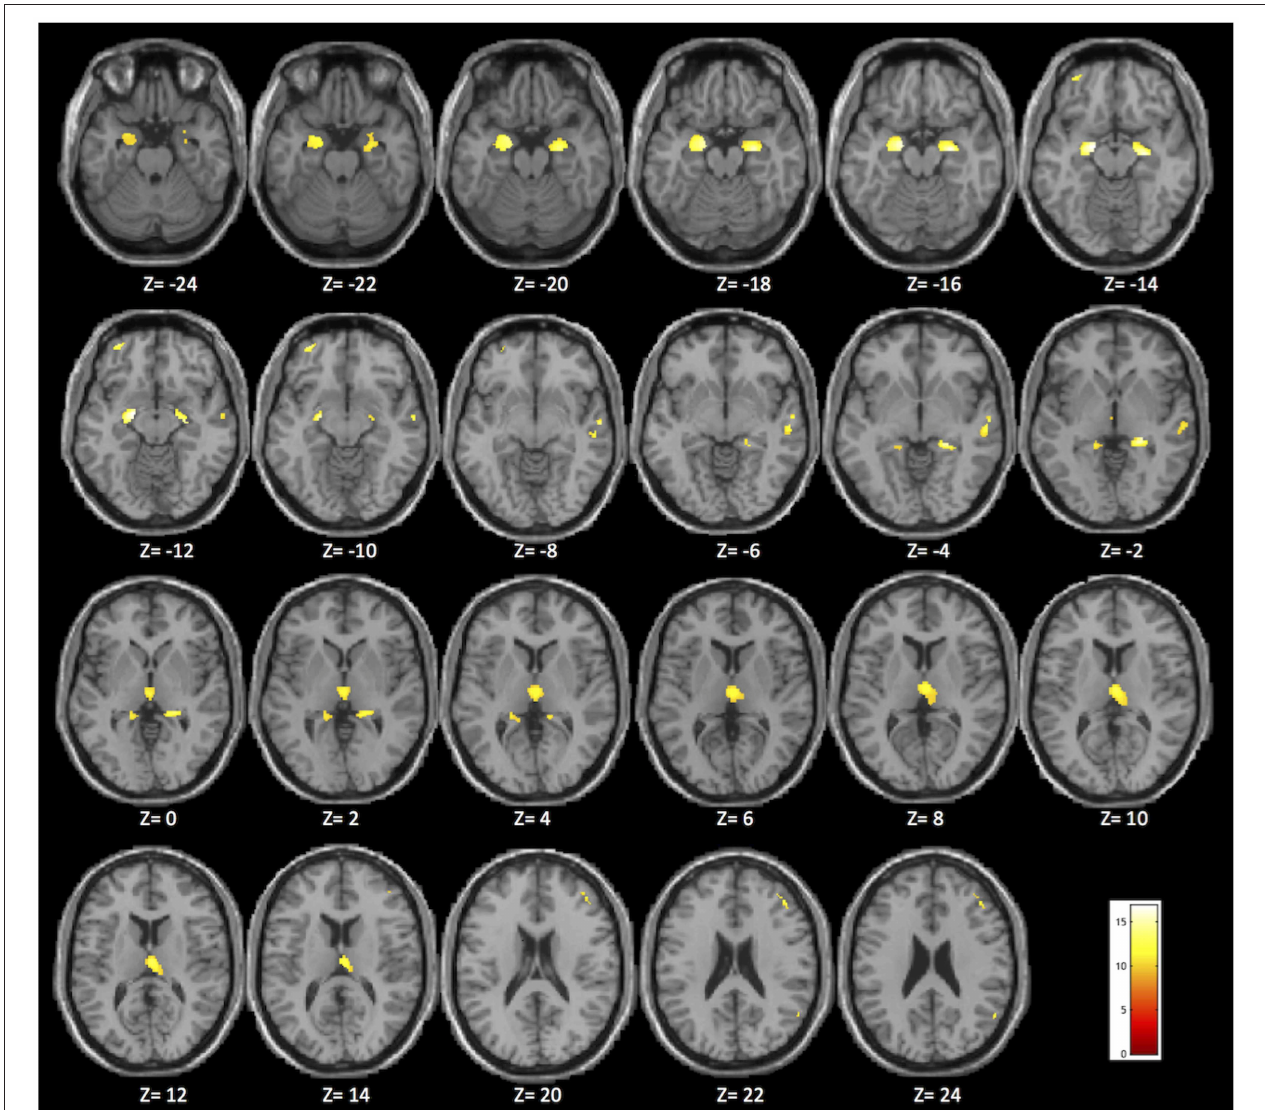
FIGURE 1 | Brain areas in which significant differences were found among the MCI ε 4 + / + , MCI ε 4 + / − , MCI ε 4 − / − , and control groups in the whole-brain voxel-based morphometry (VBM) analysis ( p < 0.05 family-wise error (FWE) correction for multiple comparisons in the whole brain). The significant regions are superimposed on a standard template, with Montreal Neurological Institute (MNI) coordinates indicated at the bottom of each